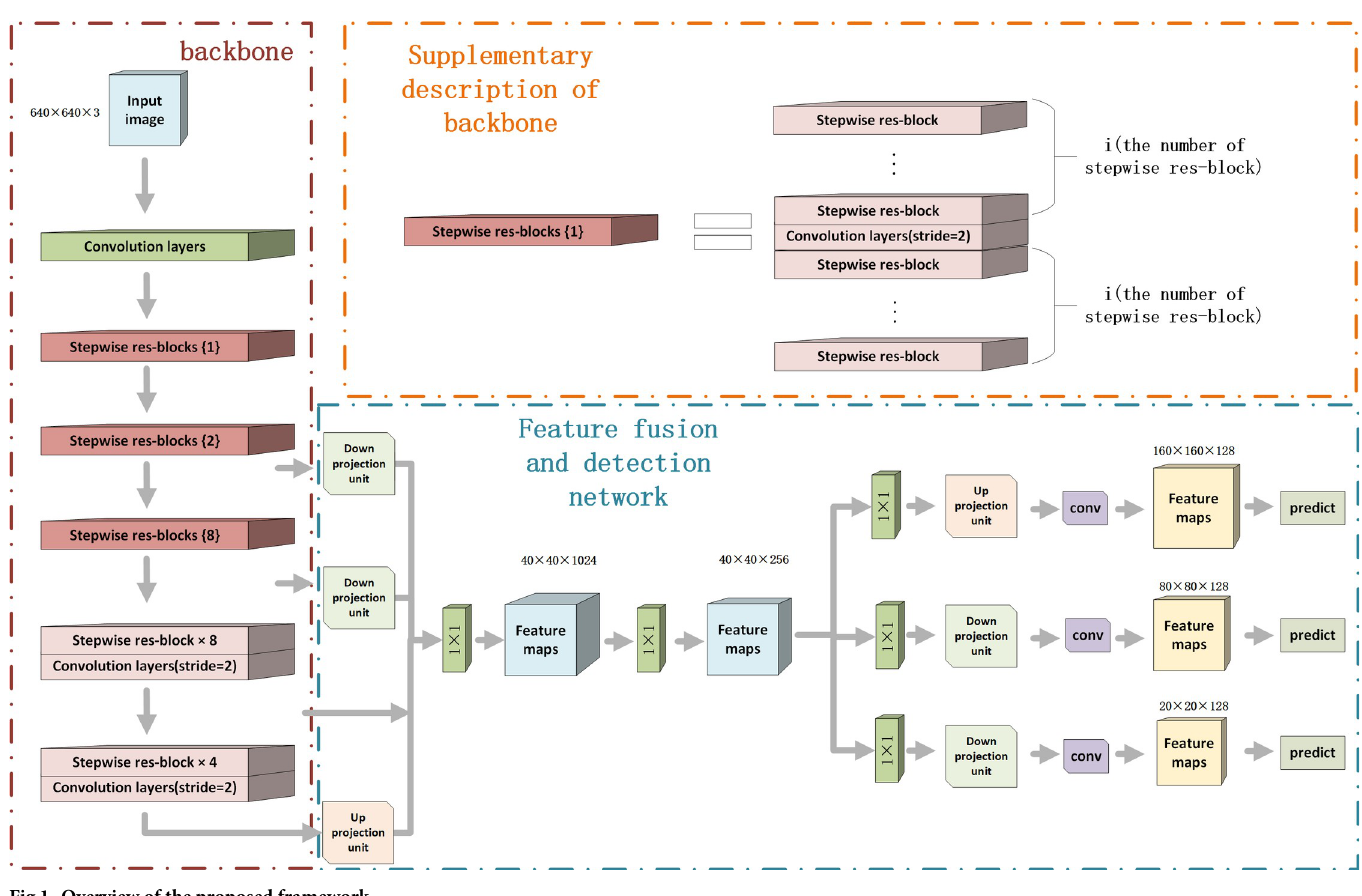
Fig 1. Overview of the proposed